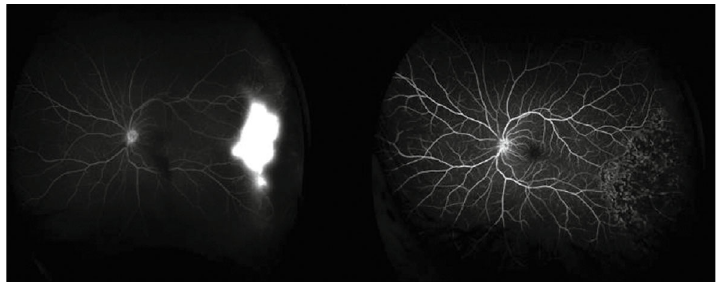
Figure 3: Neovascularization regressed after laser treatment in the left eye.